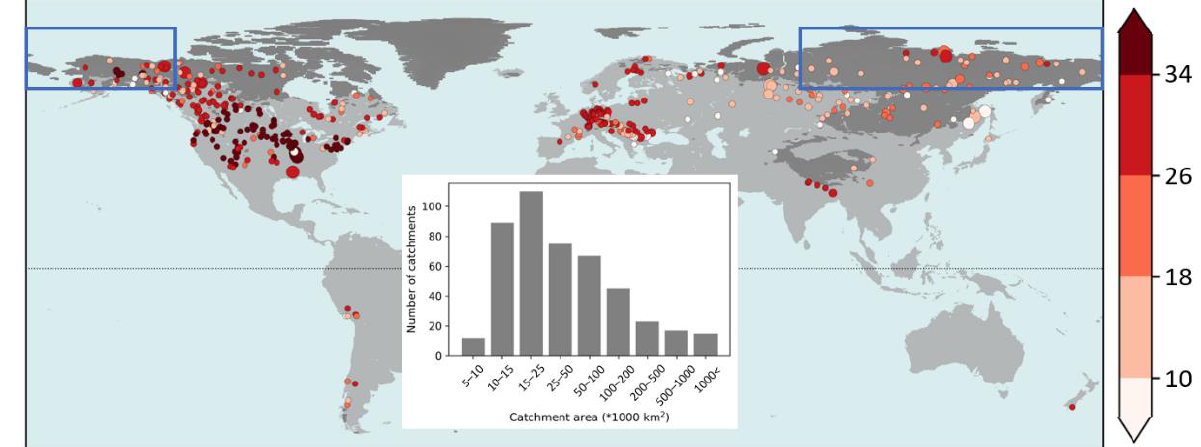
Figure 1. Stations used in this study with the number of river discharge observation years available (8 years is the minimum). In total, 453 catchments worldwide. The darker grey shading indicates the permafrost areas (defined as the area where the lowest soil layer’s temperature is below 0 °C in the ERA5 climate mean on 1st of June, based on 1980 – 2018), while the blue rectangle shows the sensitivity area defined in the permafrost. The distribution of the catchment upstream area values is provided in the inset table (please note the area values are divided by 1000).